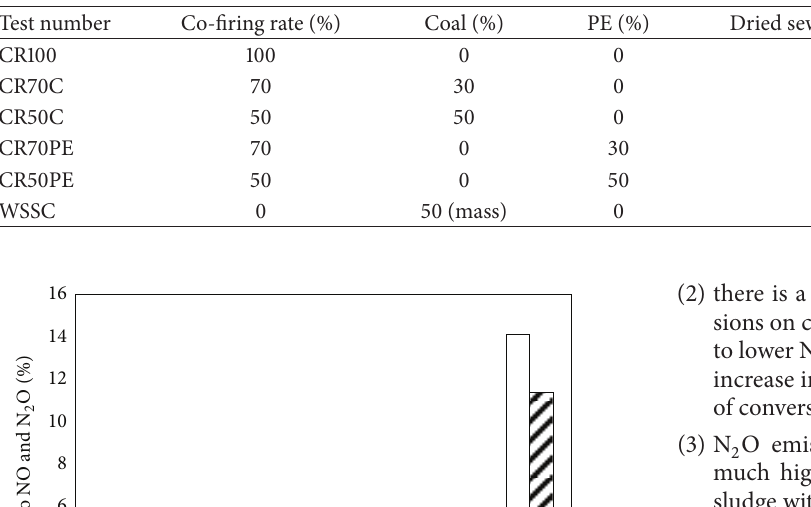
Table 4: The co-firing rate test conditions.